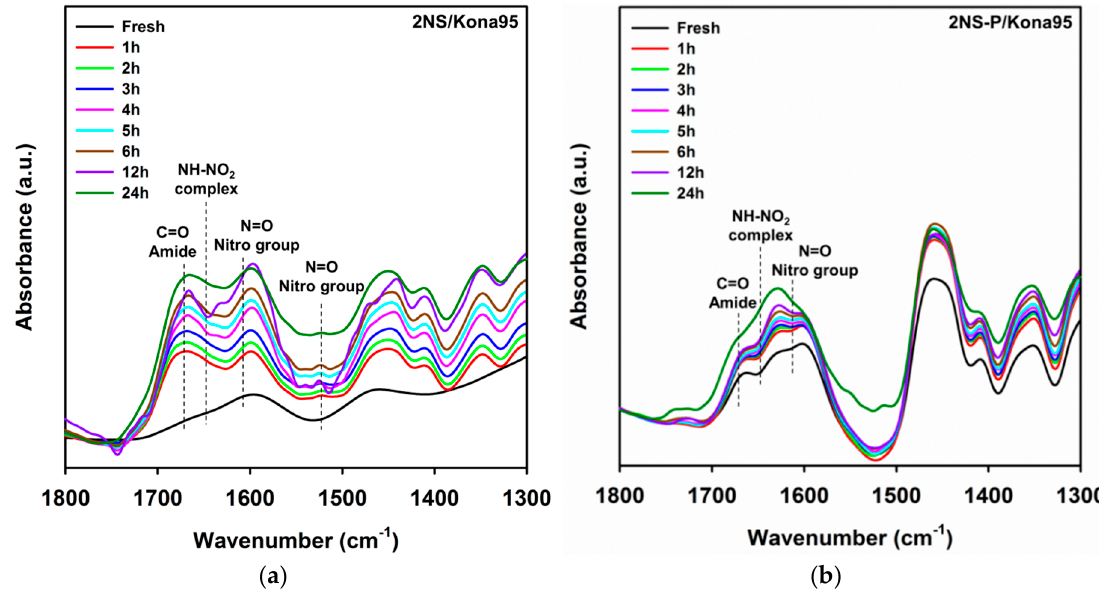
Figure 8. Changes in the in situ FT-IR spectra of ( a ) 2NS / Kona95 and ( b ) 2NS-P / Kona95 exposed to 50 ppm NO 2 at 110 ◦